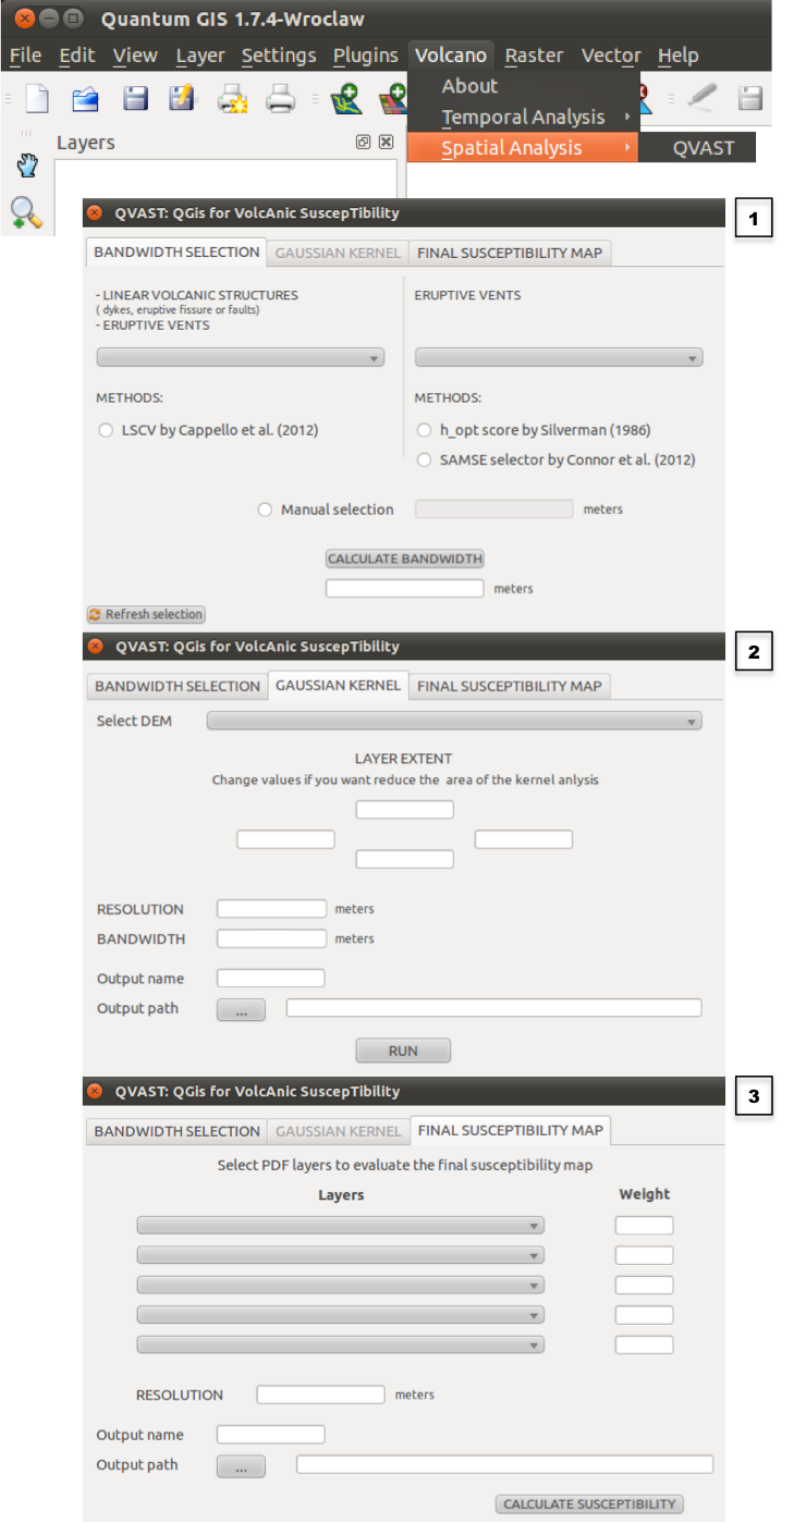
Fig. 2. QVAST main interface: screenshots of the optimal bandwidth selection (1), for the parameter needed by the Gaussian kernel (2) and for the assignment of weights to the different PDFs